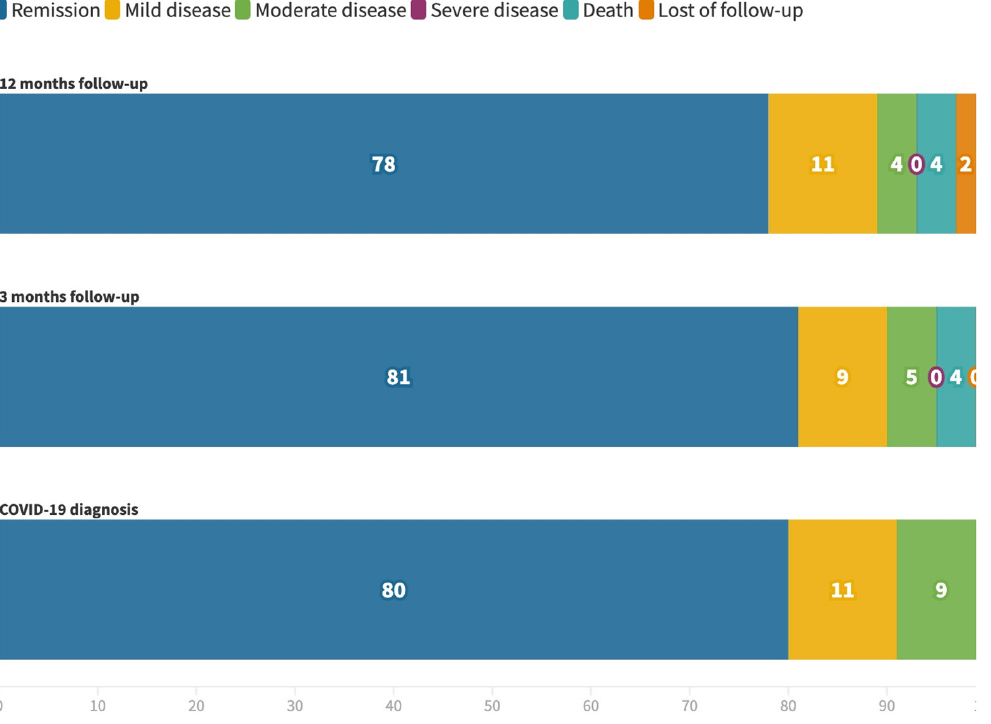
Figure 2. Inflammatory bowel disease activity at COVID-19 diagnosis and 3- and 12-month